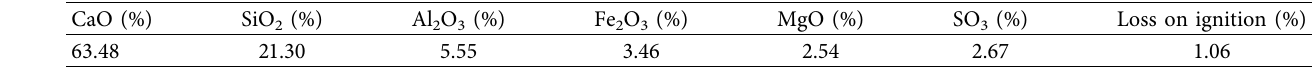
Table 4: Chemical composition of the cement.